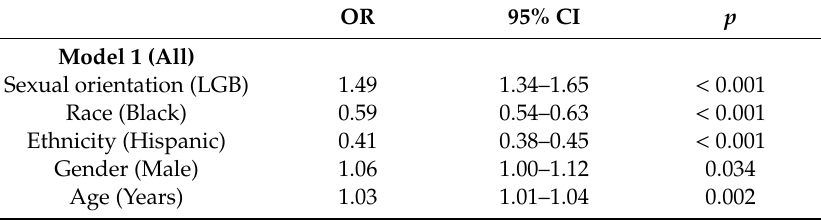
Table 3. Logistic regressions on current smoking models in the pooled